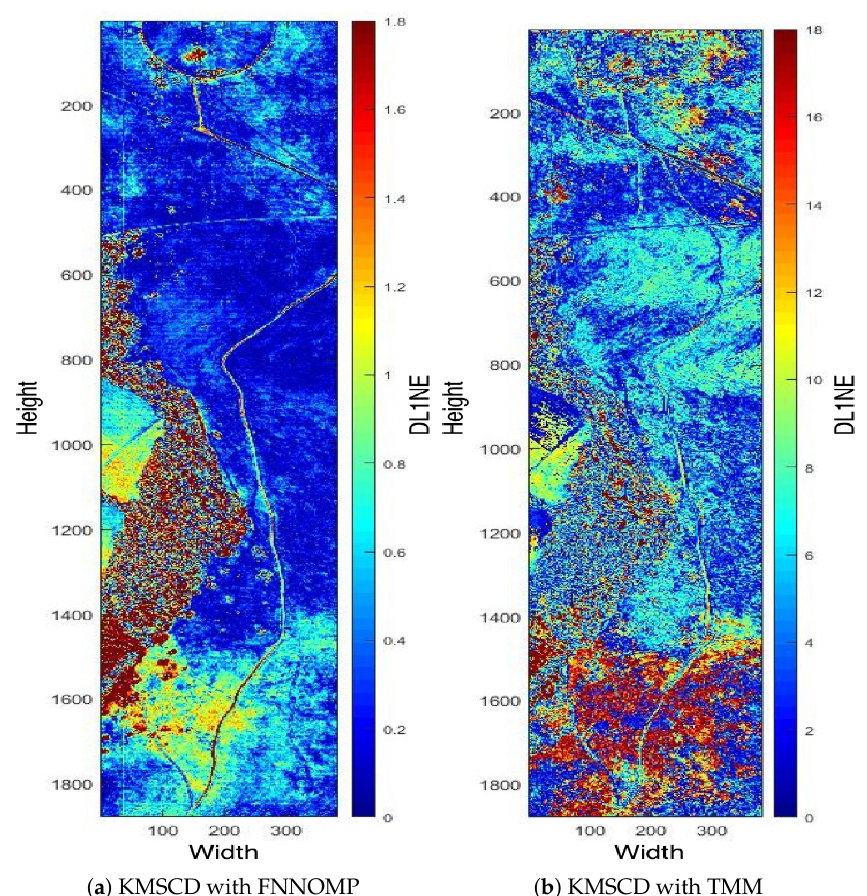
Figure 10. Selene H23 Dual scene by ( a ) the KMSCD+FNNOMP (Algorithm 2) and ( b ) the KMSCD+TMM. The mean errors of the entire map for panels (a,b) are 0.74% and 7.12%, respectively, showing the superiority of the FNNOMP over the TMM for constraining N mp to four materials per pixel.